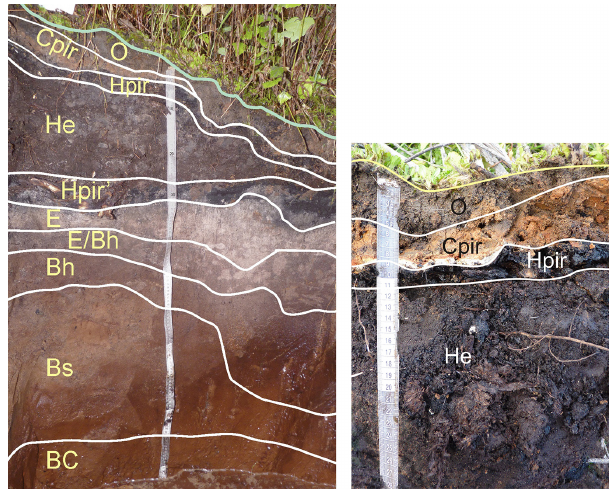
Figure 4. Soil profiles investigated. 1-post-pyrogenic histic podzol (pit 6), 2-post-pyrogenic histosol (pit